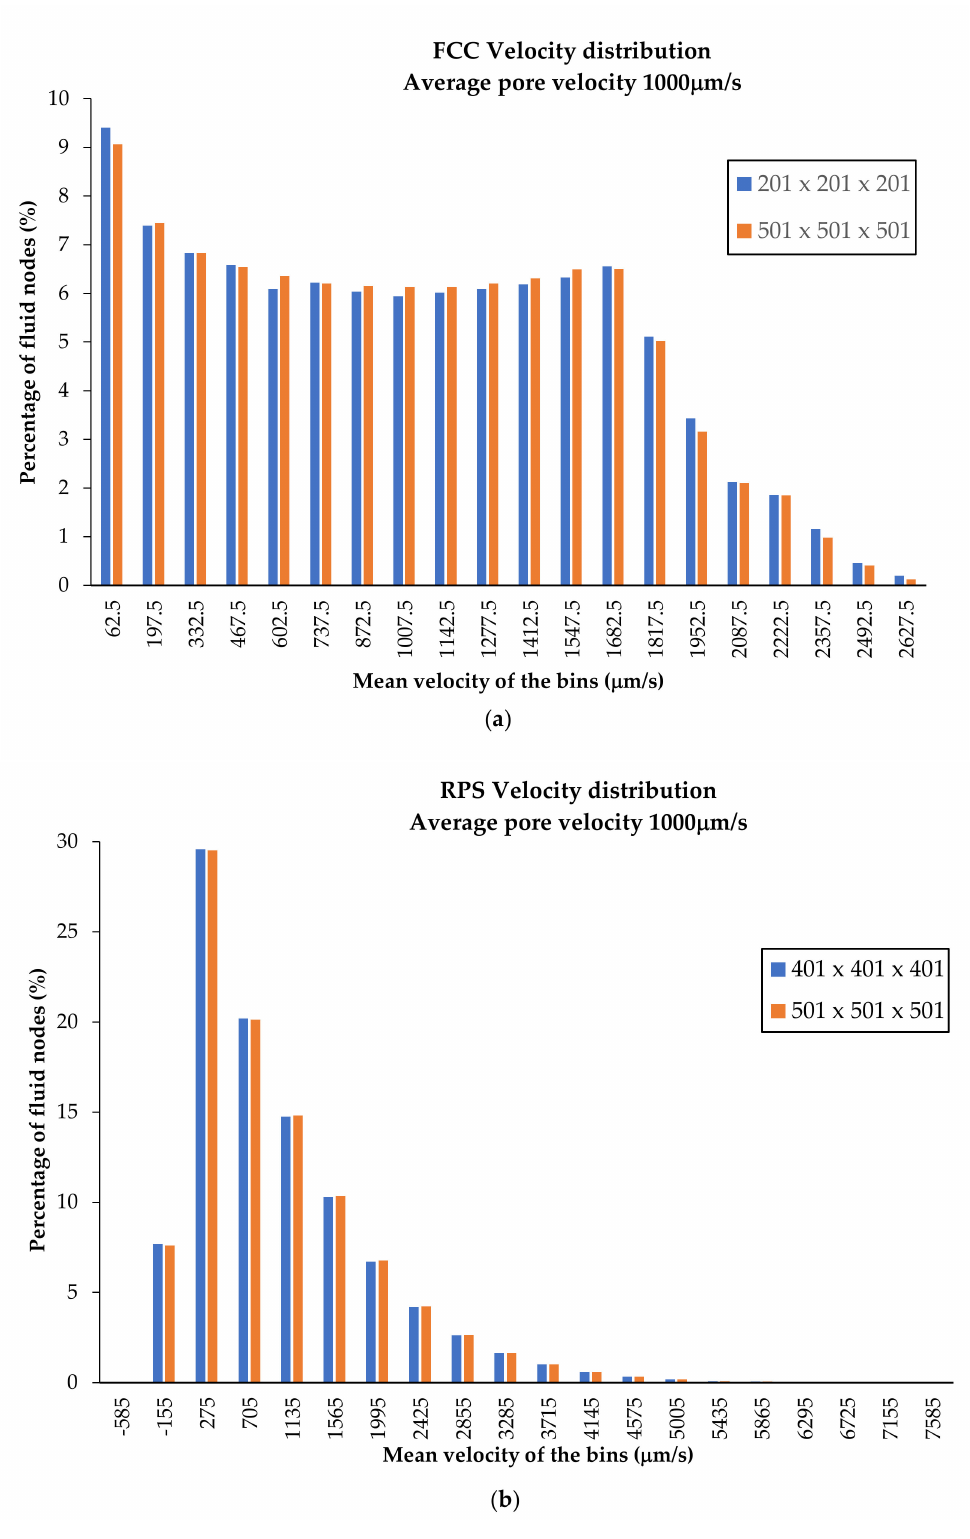
Figure A2. The velocity distribution profiles for the flow fields in ( a ) FCC domains with resolutions of 201 × 201 × 201 and 501 × 501 × 501 and ( b ) RPS domains with resolutions of 401 × 401 × 401 and 501 × 501 × 501. The x-axis shows the mean velocity of the bins, while the y-axis shows the percent of the fluid nodes with the velocity in the range of the corresponding